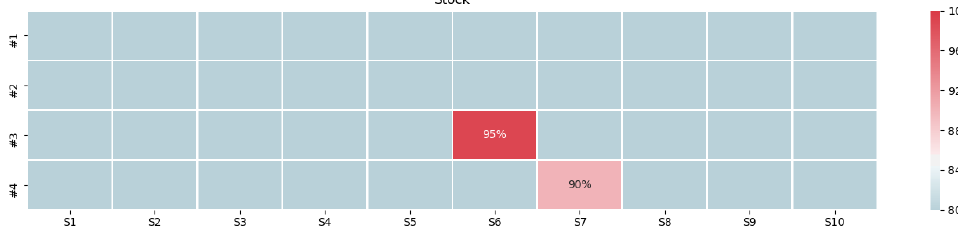
Figure 9. Warehousing out: What prediction range the actual value belongs